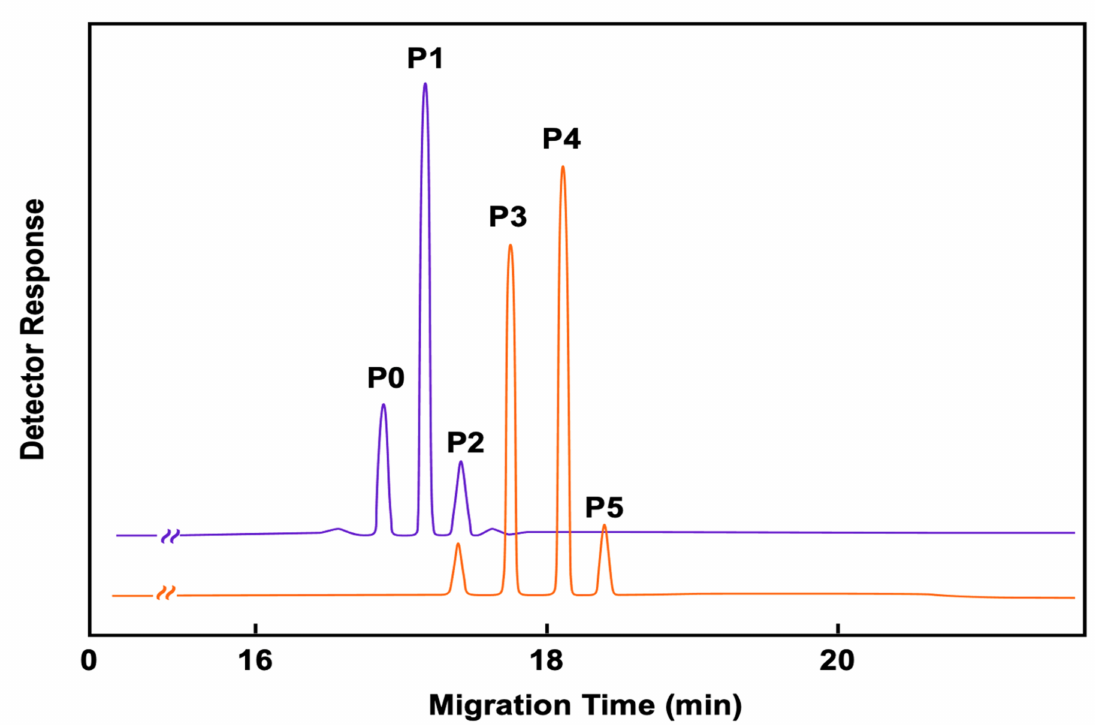
Figure 8. Depicts some changes occurring in an artificially created microenvironment where an intact transferrin proteoform can be altered by adding neurominidase and removing the terminal sialic acids attached to transferrin. The separation and quantification profile of the intact transferrin isoforms changes due to the removal of sialic acids which alter the mass/charge ratio of the molecules. This electropherogram was performed with an ultra-low background system that combines an advanced detector technology with signal processing algorithms. Figure modified from